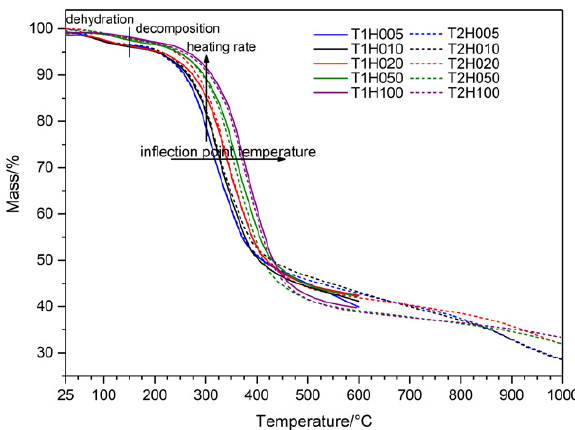
Figure 2. Inflection point determination for the dynamic pyrolysis curves up to 600 °C and up to 1000 °C at all heating rates (5 °C min − 1 ,